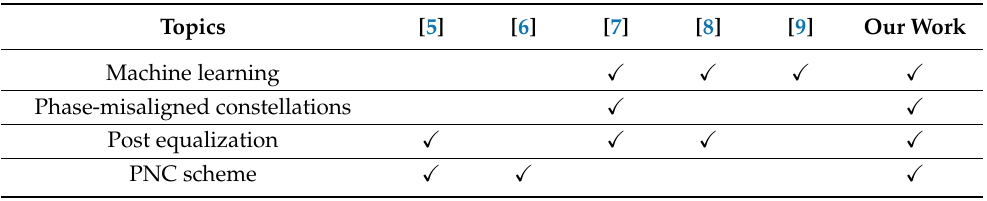
Table 1. Contribution comparison of VLC